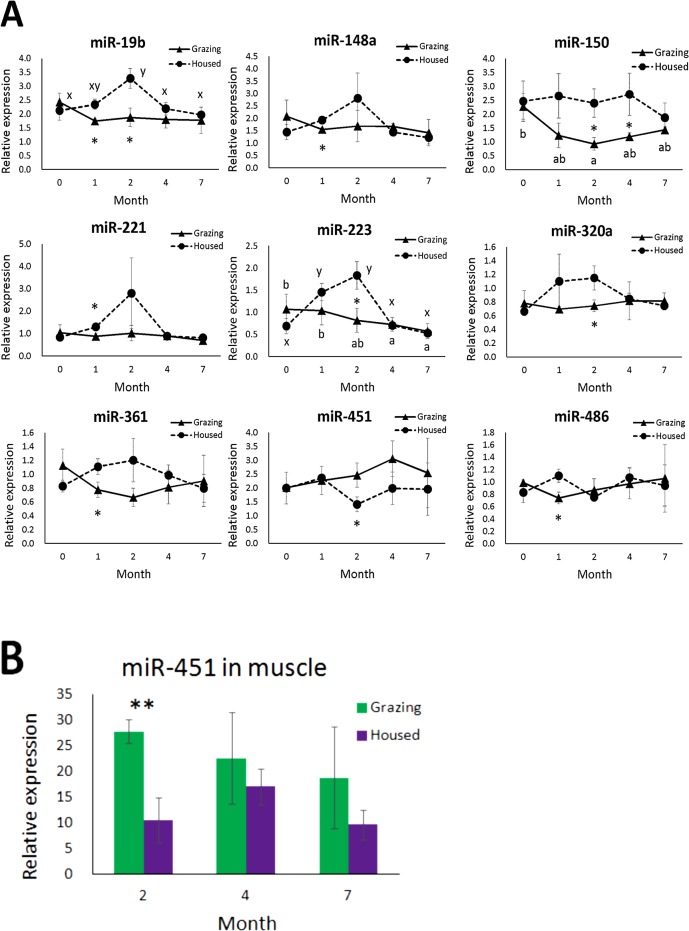
Changes in levels of 9 plasma exosomal miRNAs (A) and muscular miR-451 (B) of grazing and housed cattle analyzed by qRT-PCR.Data of grazing and housed cattle are indicated as solid and broken lines in panel A, and green and purple columns in panel B, respectively. Different letters among the time points indicate differences at P < 0.05 in the grazing (x, y) and housed cattle (a, b). An asterisk and double asterisks indicate differences between the cattle groups at P < 0.05 and P < 0.01, respectively.